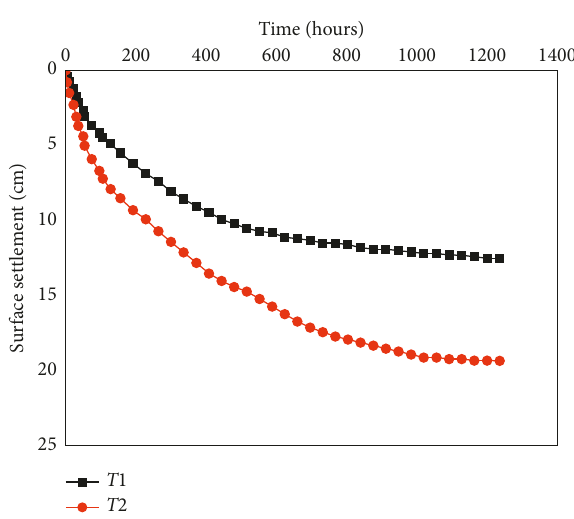
Figure 5: Surface settlements plotted as functions of time for cylinders T 1 and T